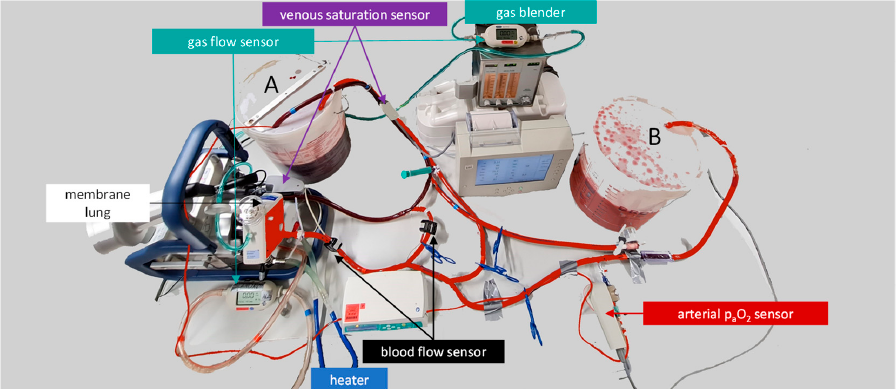
Figure 1. Schematic layout of the mock circuit. The mock consists of two buckets (A and B) as